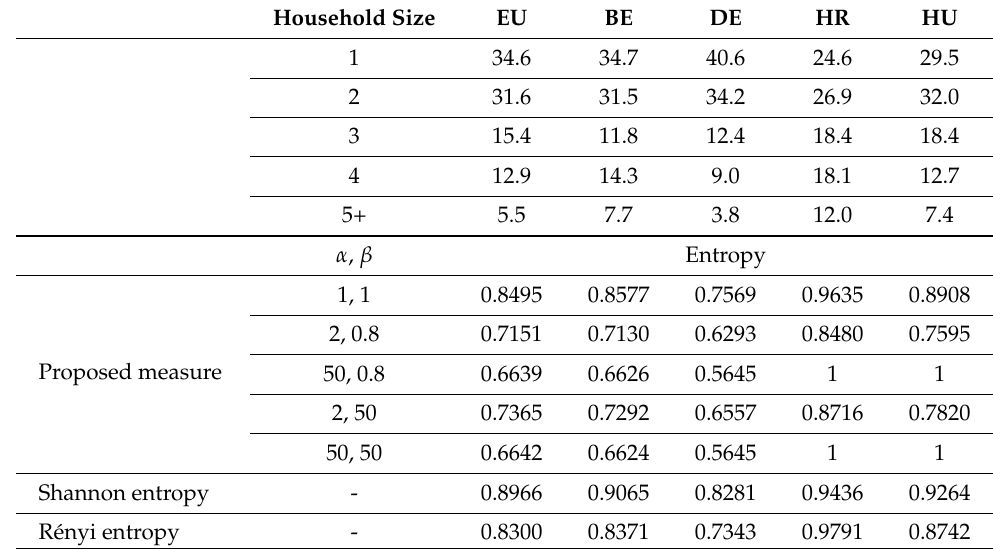
Table 4. Entropies for the distribution of household sizes in EU and four EU countries.